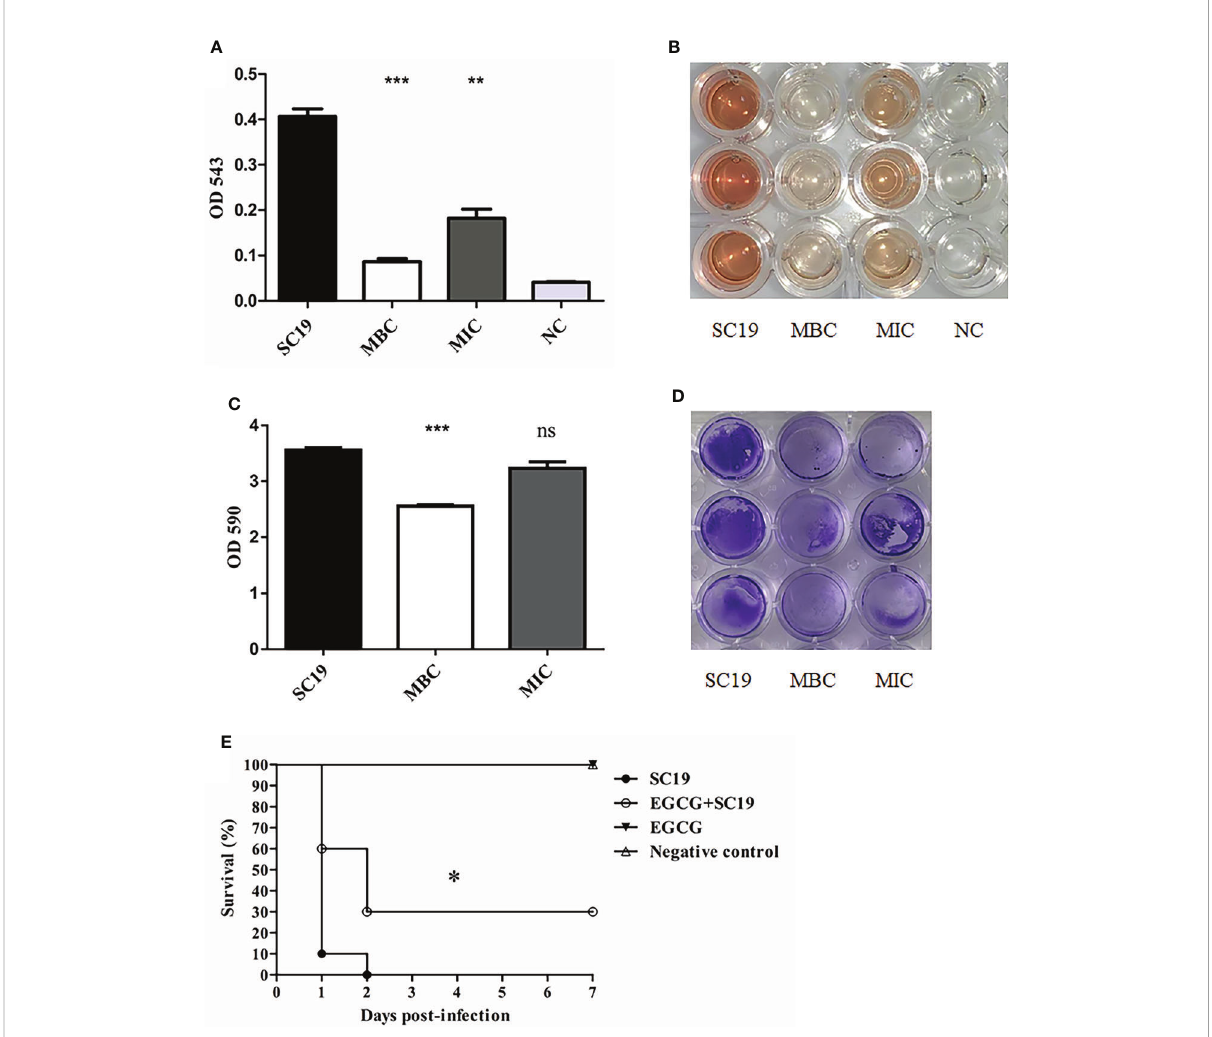
FIGURE 3 Hemolytic activity, bio fi lm formation and infection experiment and of SC19 affected by EGCG. (A) Hemolytic activity analysis of SC19 affected by EGCG. Absorption was measured at 543 nm to determine Sly production. TSB was used as negative control. (B) Microplate showing difference of hemolytic activity between EGCG treated SC19 and untreated SC19 (C) Bio fi lm formation analysis of SC19 affected by EGCG. Absorption was measured at 590 nm to determine bio fi lm production. TSB was used as negative control. (D) Microplate showing difference of bio fi lm formation between EGCG treated SC19 and untreated SC19. (E) Survival curves for Galleria mellonella larvae in experiment infection. Signi fi cant difference in survival between different groups was analyzed by Log Rank test. The height of the bars indicates the mean values for the relative expression data ± SEM (ns, p > 0.05; *p < 0.05; **p < 0.01; ***p <